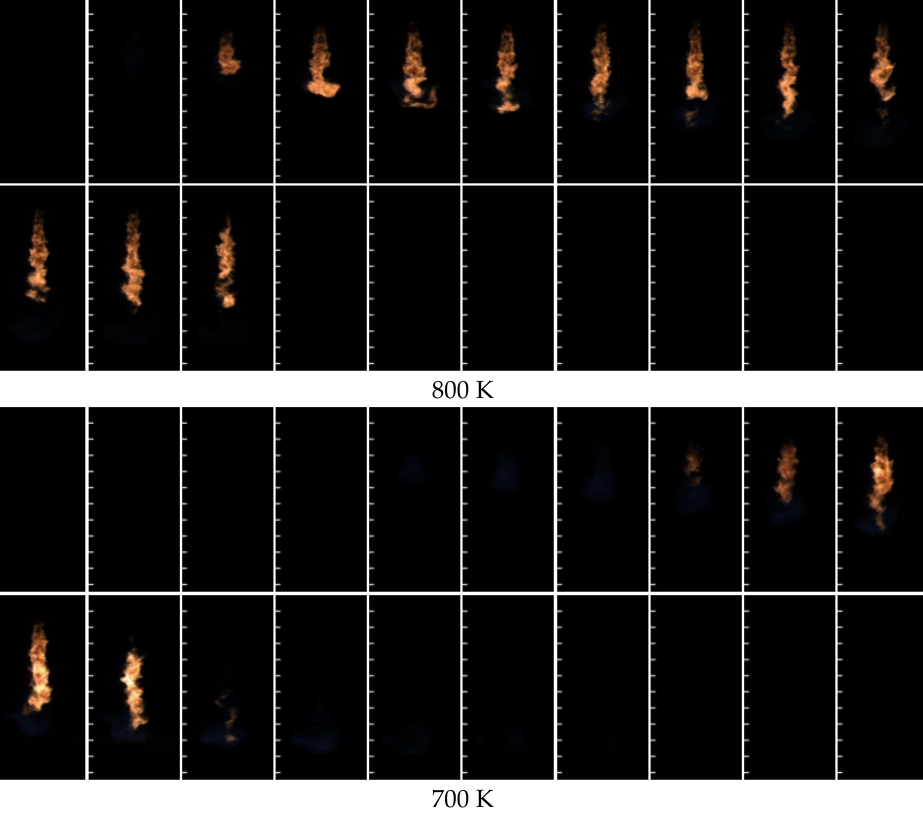
Figure 6. Influences of different initial temperatures on the diesel combustion flame in a 50% O 2 nitrogen-free environment.